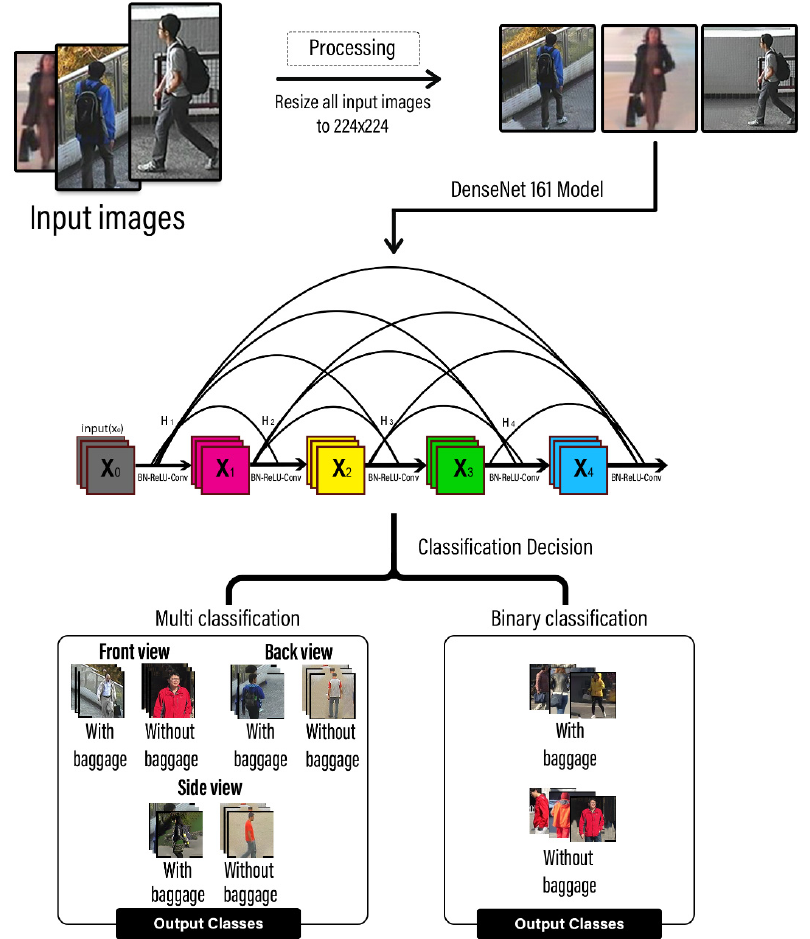
Figure 1. The processing steps in our suggested model's